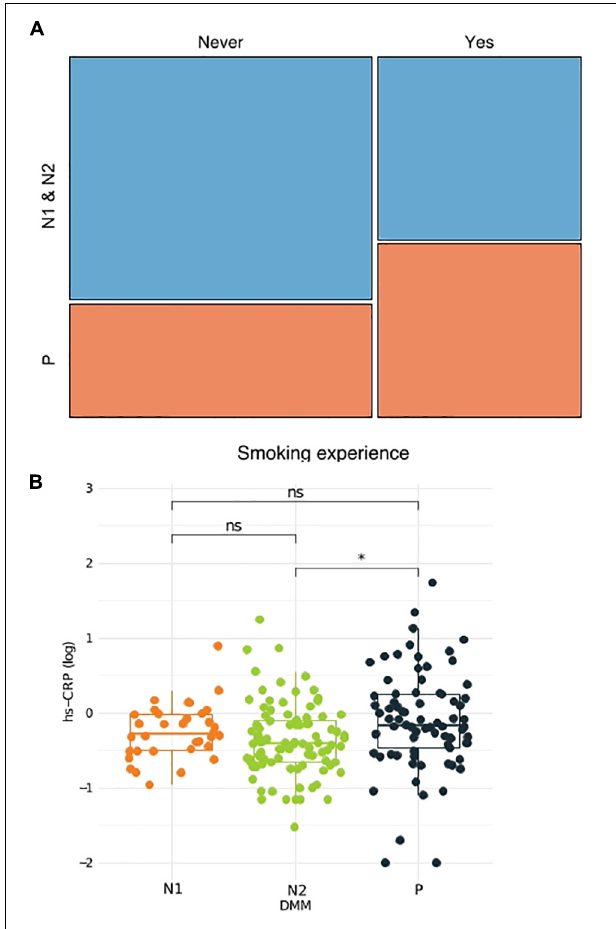
FIGURE 2 | Association between the host health status and metacommunity. (A) Subdivision of a metacommunity and the association between each subcommunity and host smoking experience. (B) A box plot and a whisker plot showing the 25th percentile, the median, the 75th percentile, and minimum and maximum data points. * q <